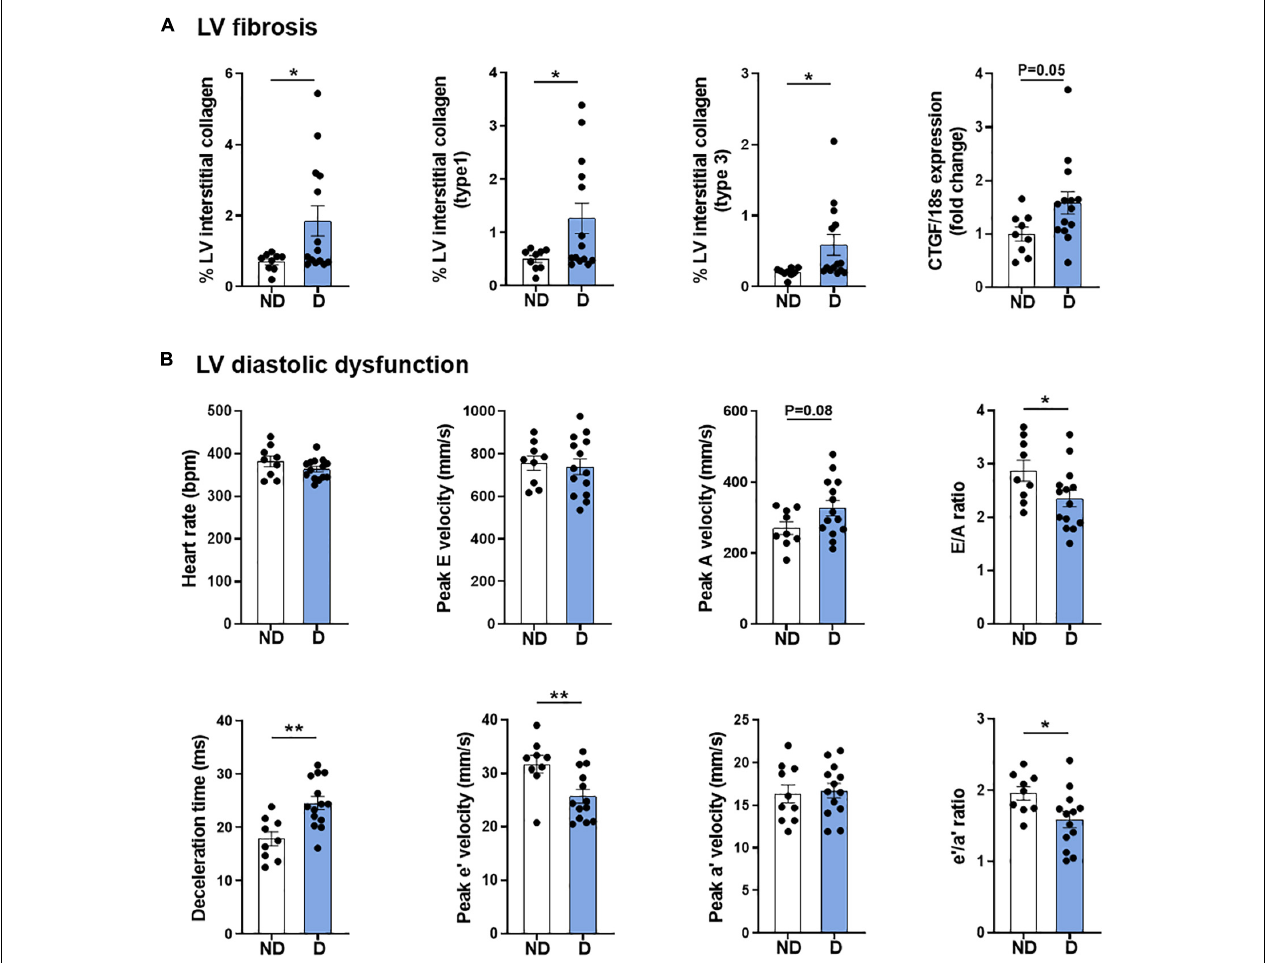
FIGURE 2 | Cardiac phenotype of diabetic mice. (A) LV fibrosis: Total interstitial collagen, type 1 collagen and type 3 collagen analysis using polarised light in picrosirius-red stained LV sections, and gene expression of fibrosis marker connective tissue growth factor (CTGF). (B) LV diastolic function: Heart rate, peak E wave velocity, peak A wave velocity, E/A ratio, deceleration time, peak e’ wave velocity, peak a’ wave velocity, and e’/a’ ratio. Data represented as mean ± SEM. n = 9–14 per group (note individual data points). Data analysis used unpaired t -test. * P < 0.05, ** P < 0.01. ND, non-diabetic; D, diabetes; H 2 O 2 , hydrogen peroxide; LV, left ventricle; NOX, NADPH oxidase; ROS, reactive oxygen